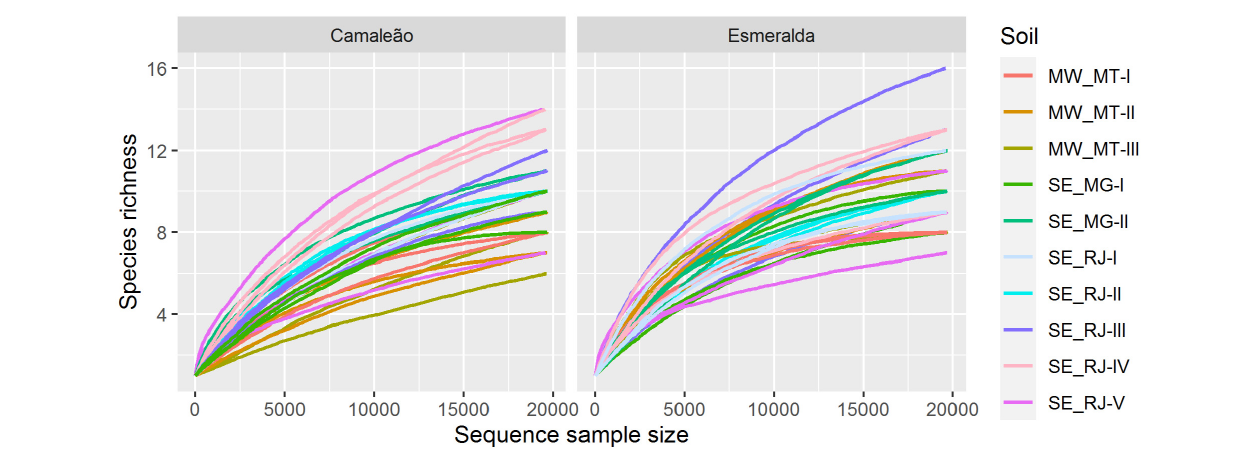
FIGURE 2 | Rarefaction curves for species richness at 97% similarity as a function of sample size for Camaleão and Esmeralda mung bean genotypes and 10 soil samples.